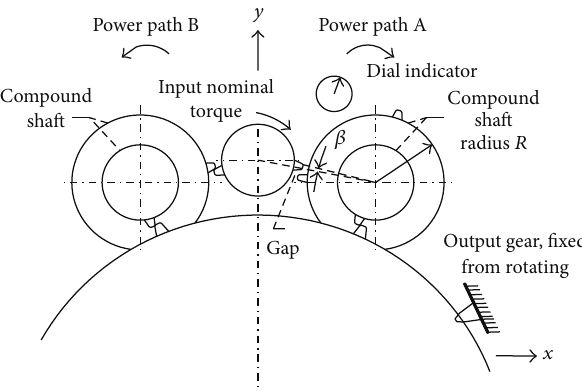
Figure 19: Illustration of conceptual experiment to measure clock- ing angle 𝛽